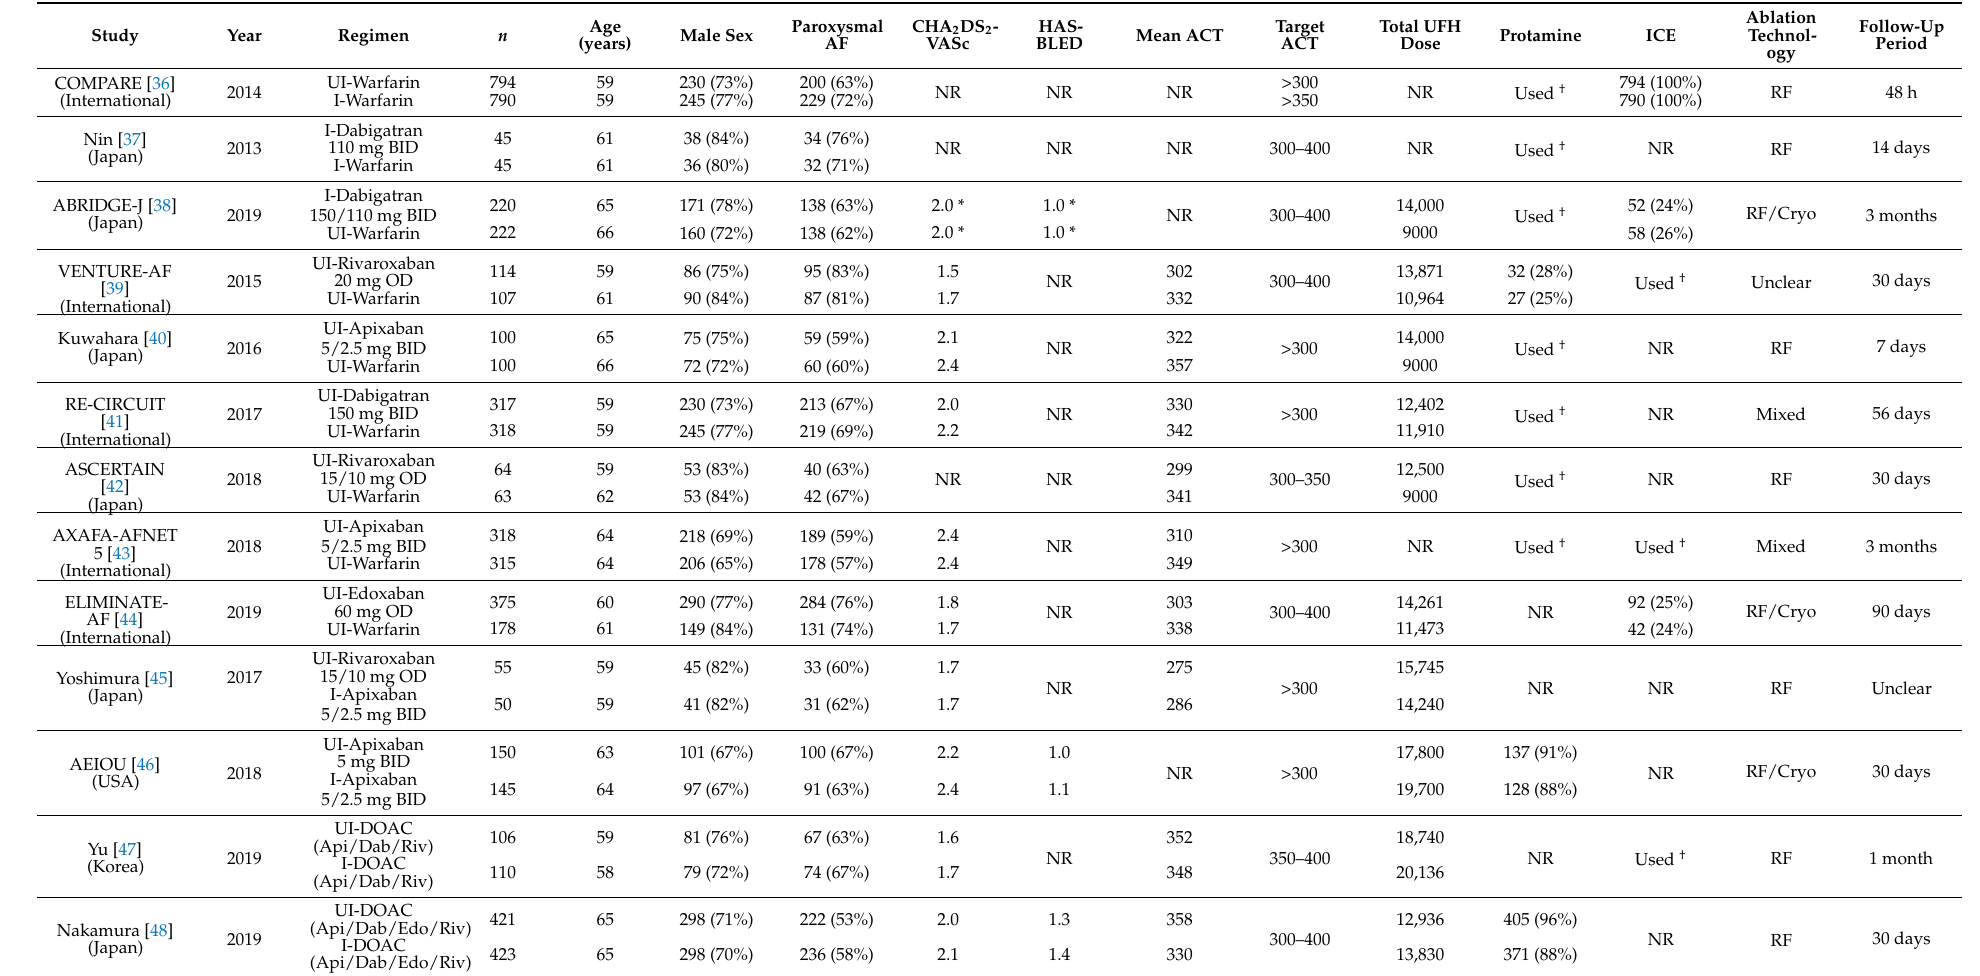
Table 1. Baseline characteristics in the included